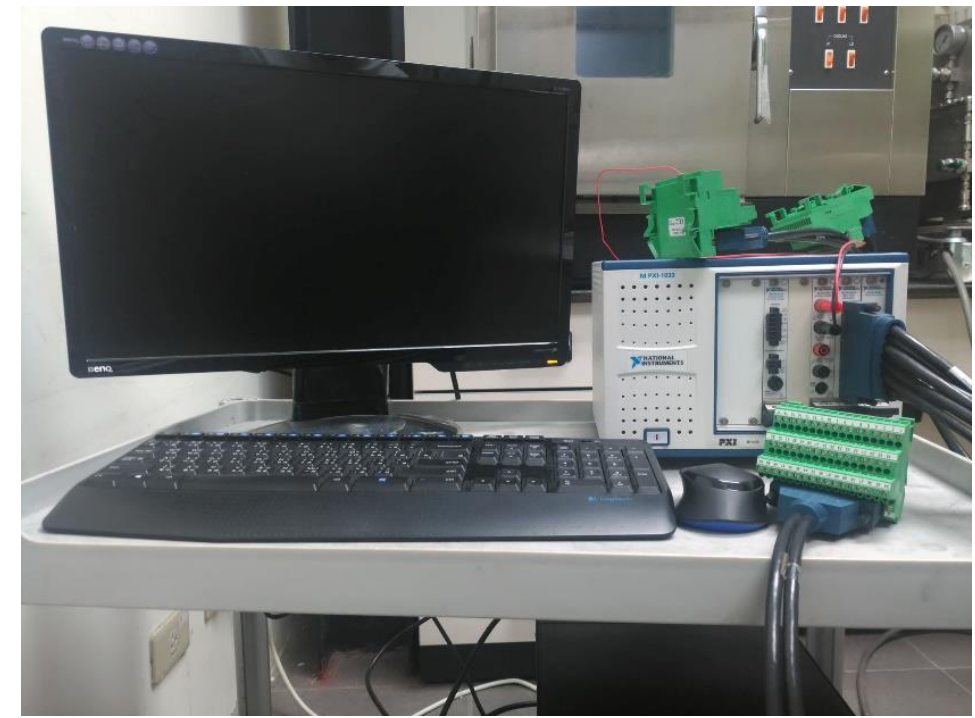
Figure 10. NI PXI 2575. Figure 10. NI PXI